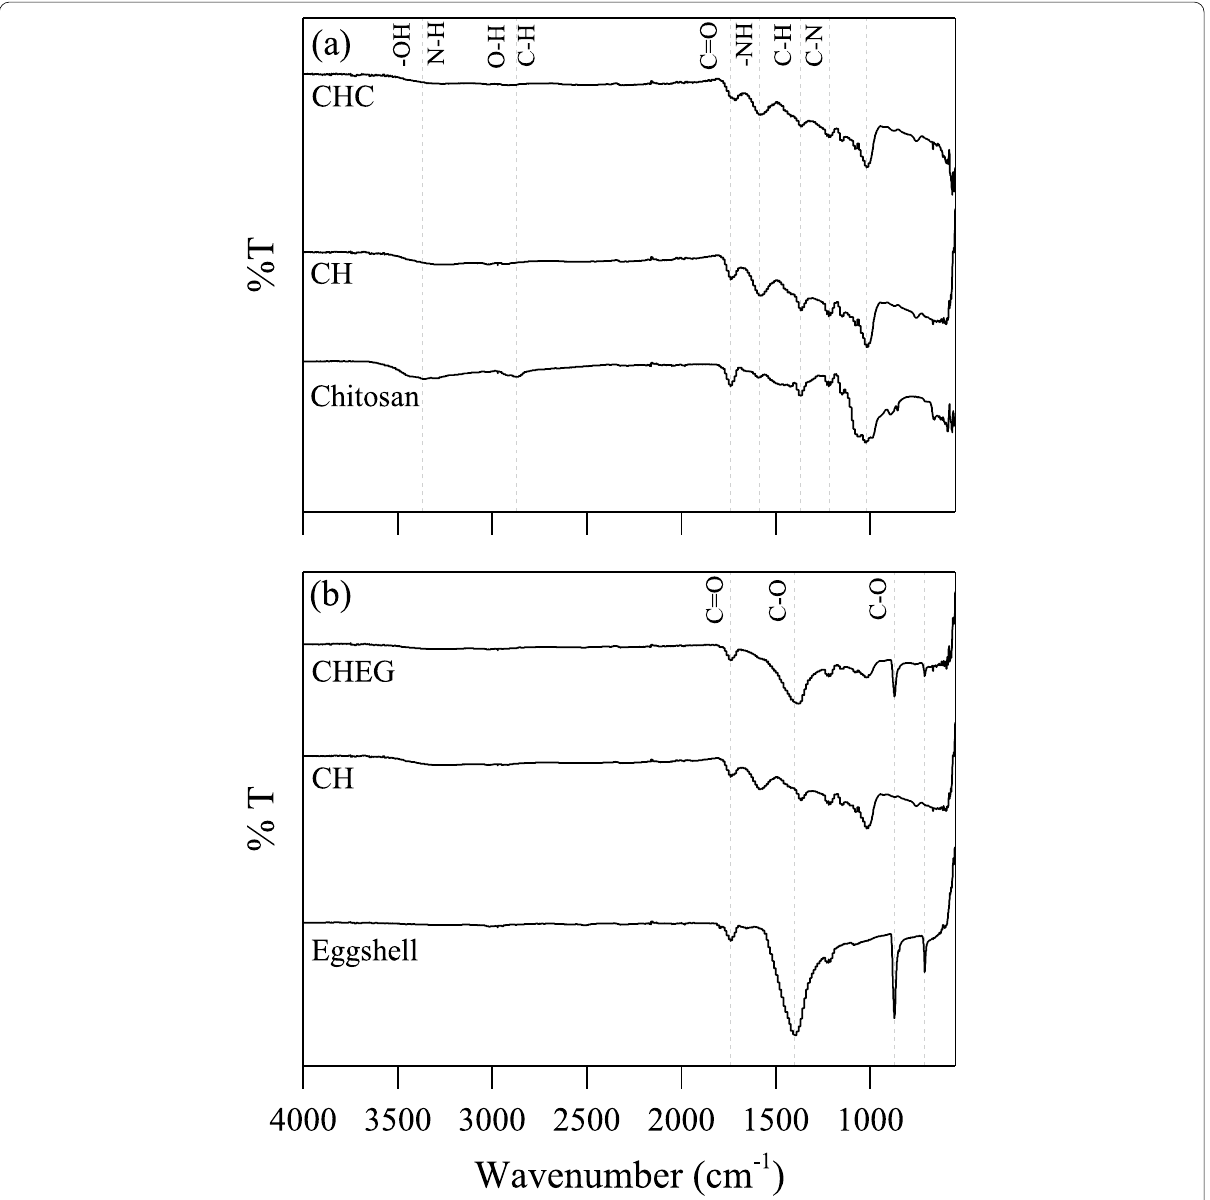
Fig. 2 FTIR spectra of biochar ( a ) CHC peaks compared with CH and chitosan powder, ( b ) CHEG peaks compared with CH and eggshell